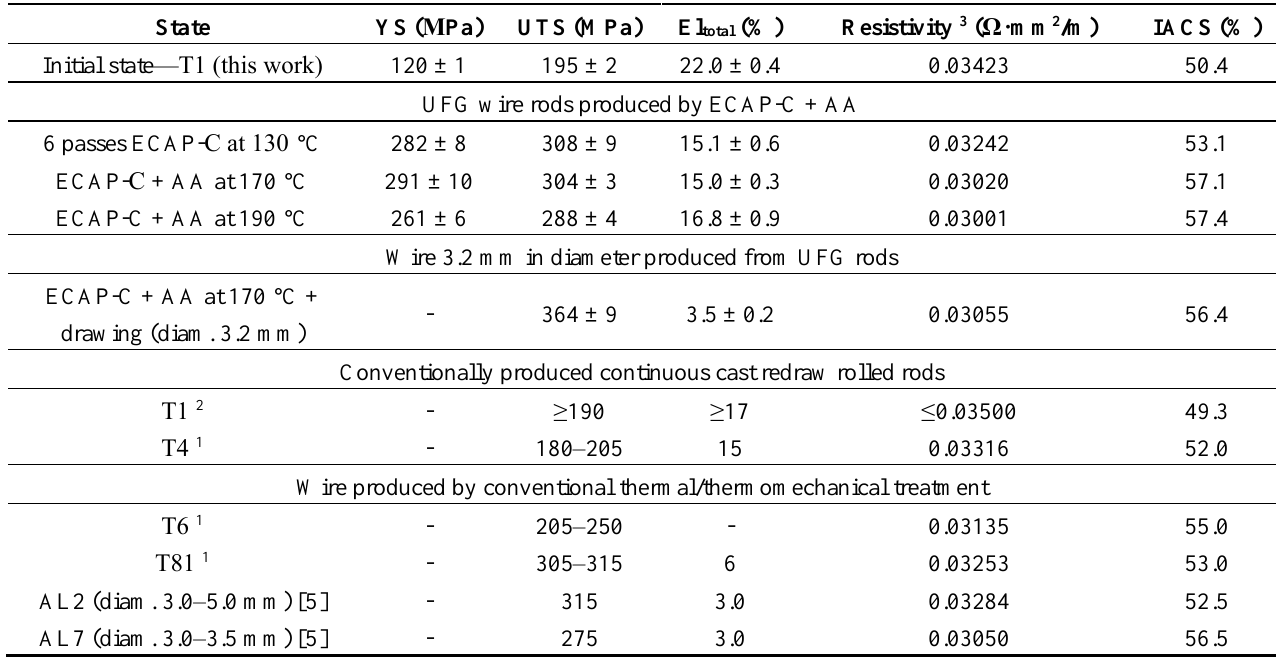
Table 2. Mechanical properties and electrical conductivity of the Al 6101 alloy.